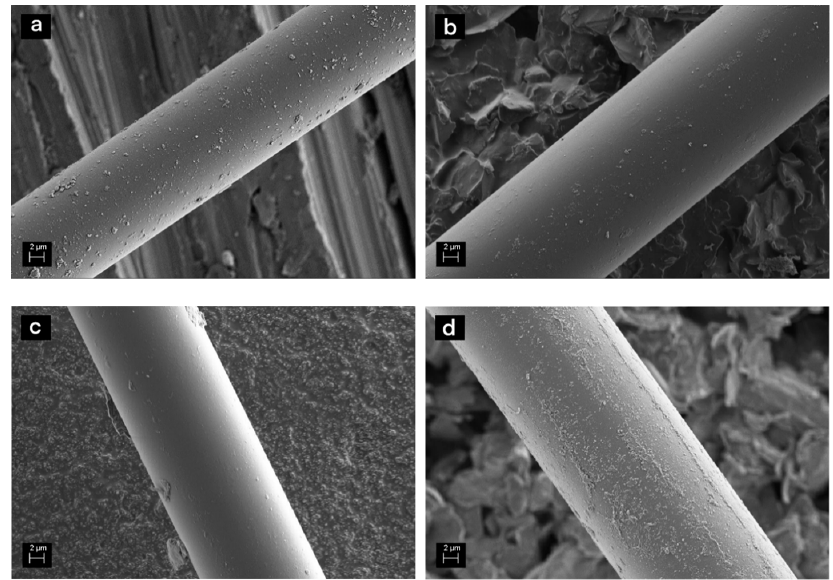
Figure 1. SEM images of ( a ) rGF before sizing, ( b ) rGF with 1 w-% PP sizing (rinsed), ( c ) rGF with 5 w-% PP sizing (rinsed) and ( d ) rGF with 5 w-% PP sizing (without rinsing). 5 w-% PP sizing (rinsed) and ( d ) rGF with 5 w-% PP sizing (without rinsing).